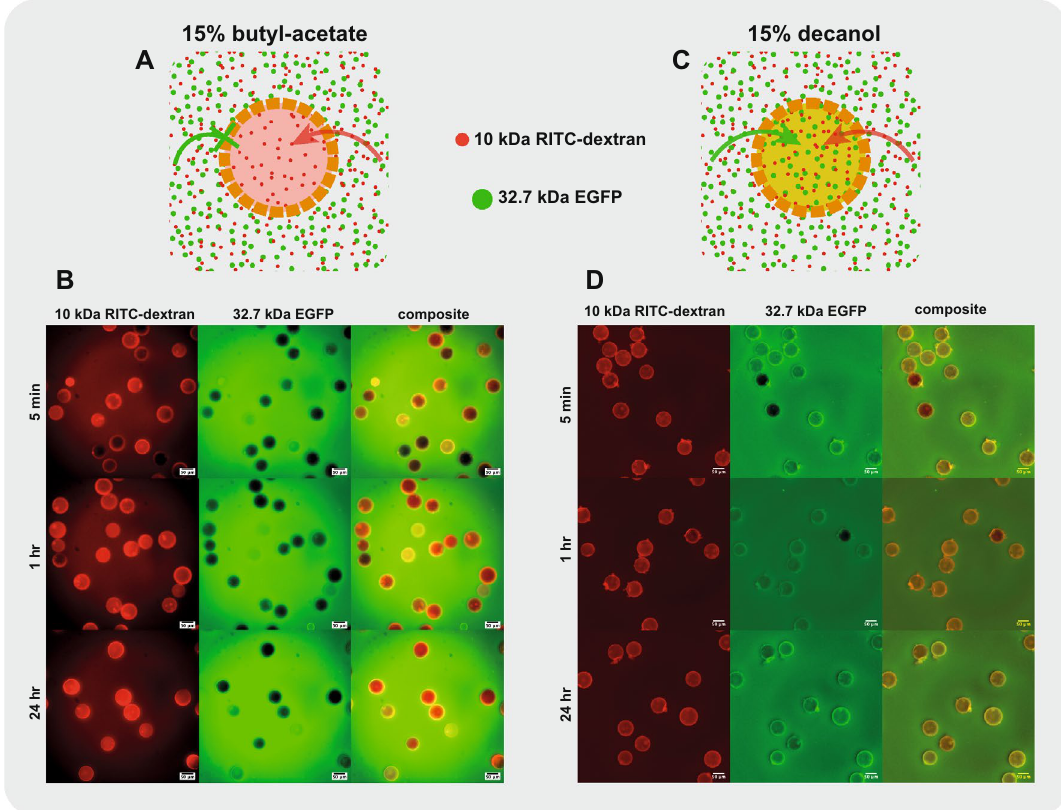
Figure 2. PEG-DA 258 microcapsules are semi-permeable and the pore size can be adjusted by changing the porogen. Schematic representation of PEG-DA 258 microcapsules produced using (A) 15% butyl-acetate or (C) 15% 1-decanol as porogen. 15% butyl-acetate microcapsules selectively allowed the permeation of 10 kDa RITC- dextran while excluding 32.7 kDa EGFP. The larger pore size of microcapsules produced with 15% 1-decanol as porogen allowed the diffusion of both fluorescent molecules. Microcapsules produced using (B) 15% butyl- acetate or (D) 15% 1-decanol porogen were immersed in a solution containing 10 kDa RITC-dextran and 32.7 kDa EGFP. The evolution of the fluorescent signal in the Cy3 and FITC channels was observed after 5 min, 1 h and 24 h. While microcapsules produced using 15% 1-decanol were permeable to both fluorescent molecules, we clearly observed the selective permeability of microcapsules produced using 15% butyl-acetate as a